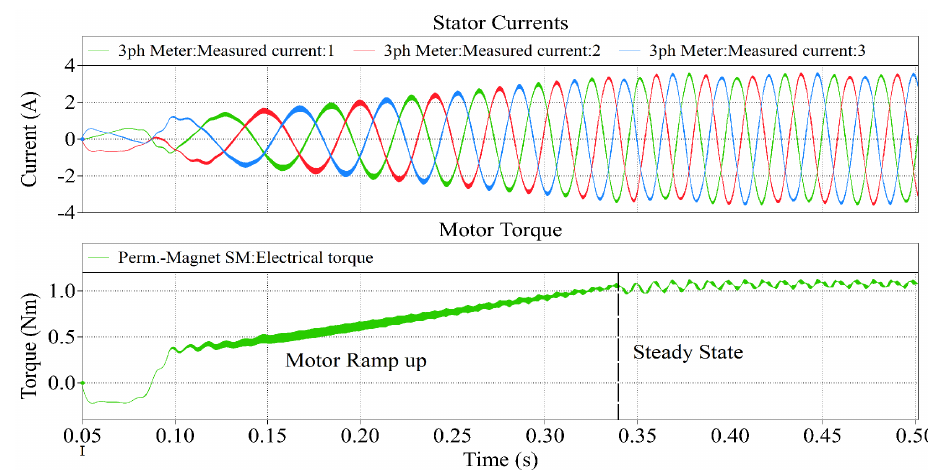
Figure 14. Time domain simulation depicting the motor stator currents i abc and torque T e . The motor stator currents i abc and torque T e in the frequency domain are presented in Figure 15. The 38 Hz frequency component can be clearly seen in the frequency spectrum. Furthermore, the frequency components of the motor torque also indicate that there is a small ripple caused by both the fundamental frequency of the VSI (38 Hz) and the output inductor current (100 Hz).